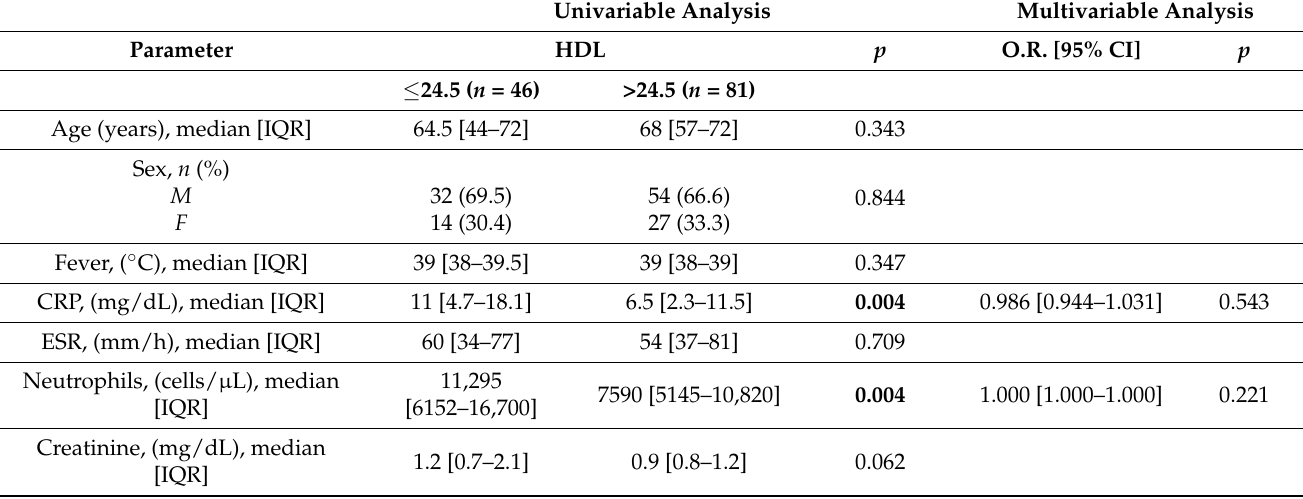
Table 3. Univariable and multivariable analysis of factors associated with a lower HDL cholesterol